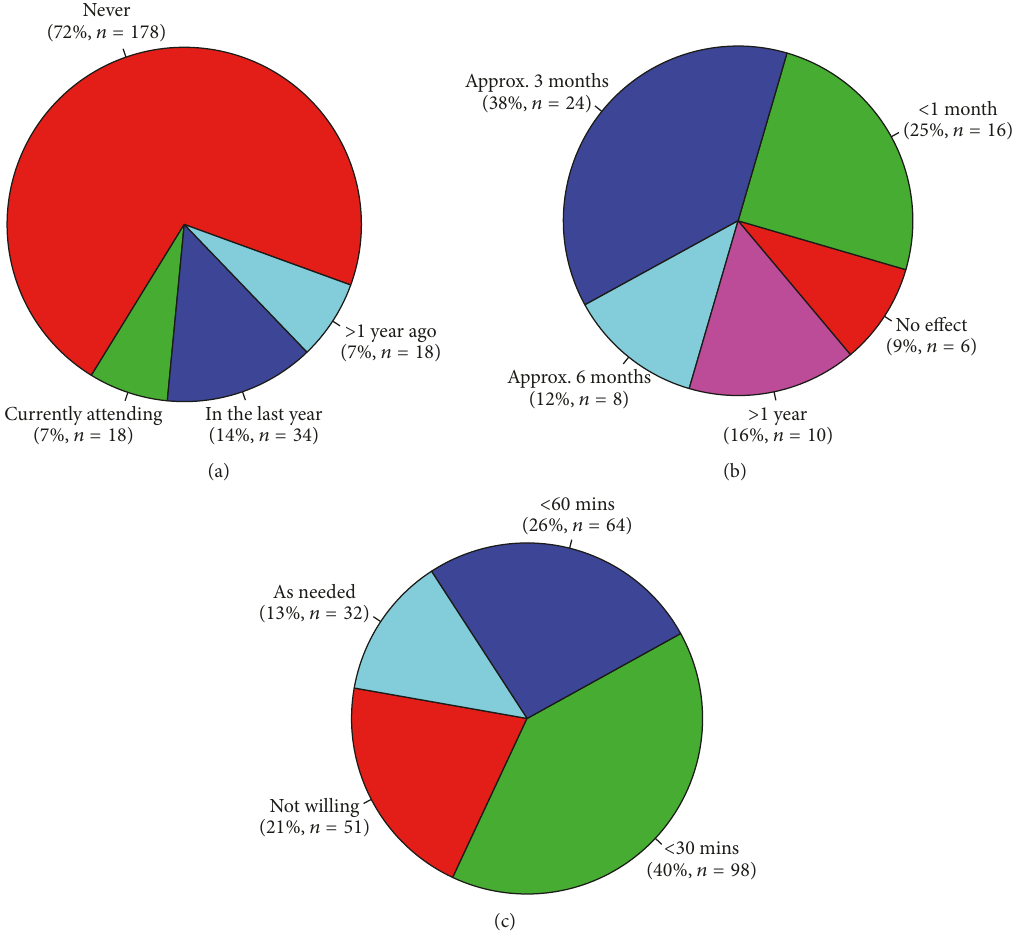
Figure 1: (a) Experience with PD specific physiotherapy ( 𝑛 = 248 ). (b) Duration of the effect of physiotherapy ( 𝑛 = 64 ). (c) Time patients are willing to travel to PT ( 𝑛 = 245